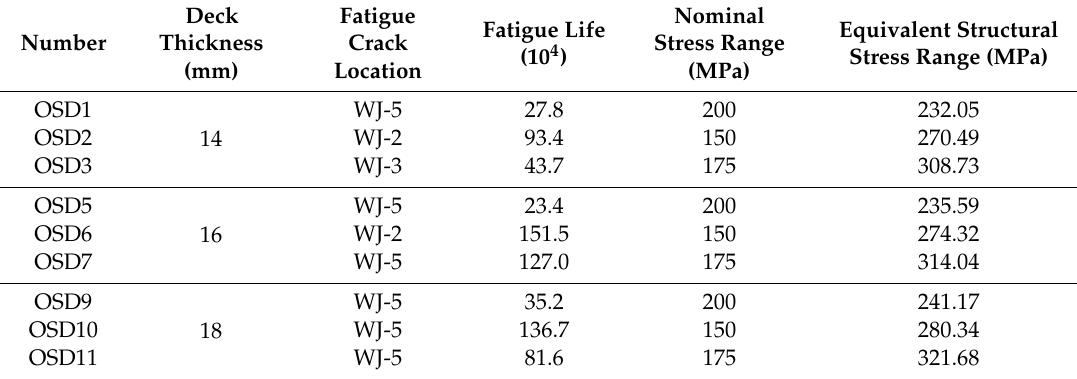
Figure 12. Strain gauges distribution in the fatigue experiments (units: mm). Table 2. Fatigue experiment results and stress parameters of the 3U component.